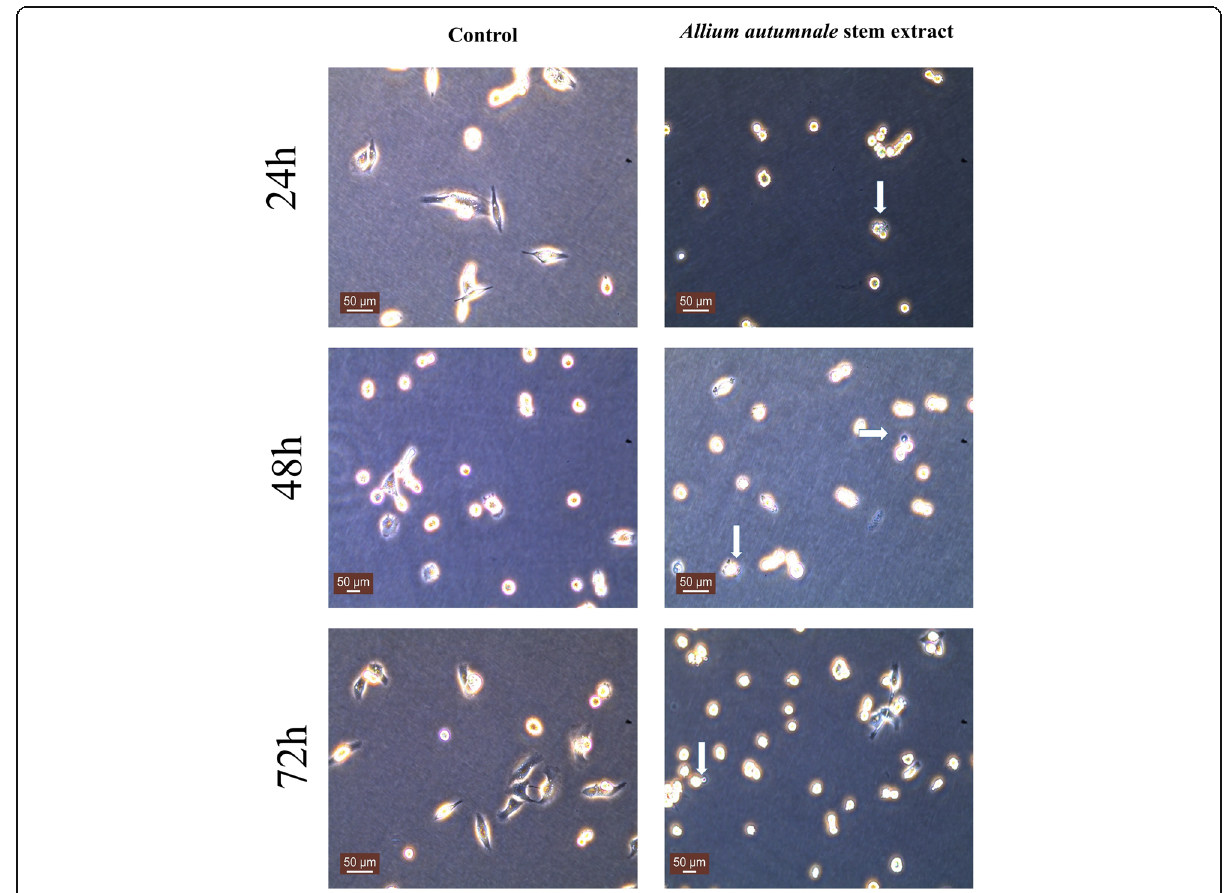
Fig. 5 AAS extract induces membrane blebbing on MDA-MB-231 cells. Light microscope images (20×) show non treated (left panel) and 2500 μ g/mL AAS extract treated (right panel). Arrows indicated plasma membrane blebbing after incubations with Allium autumnale stem extract. Scale Bars=50 μ